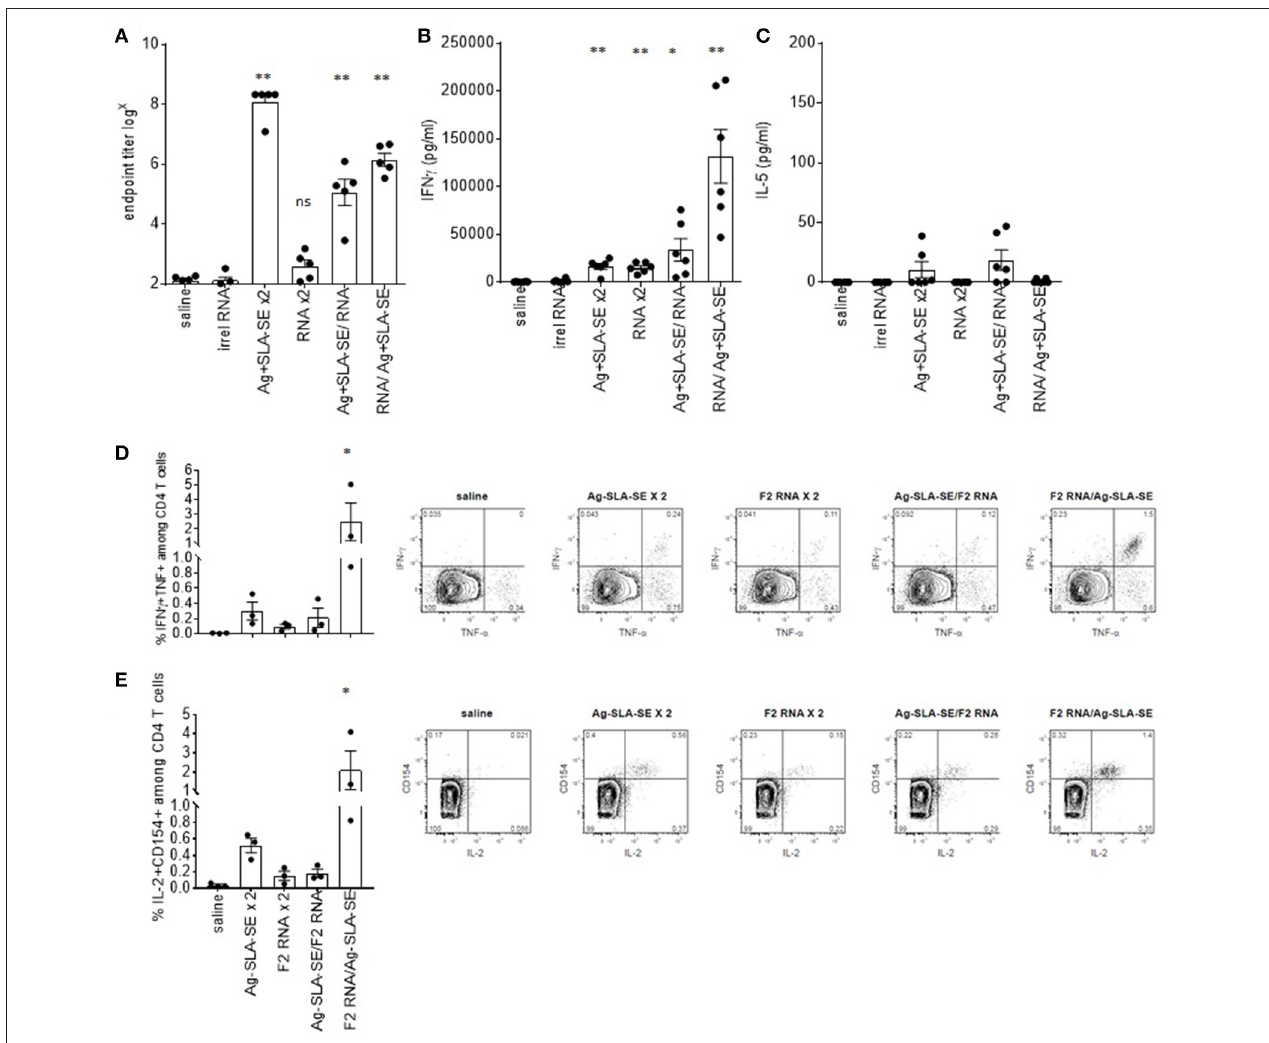
FIGURE 4 | Dichotomous generation of humoral and cellular immunity by subunit and RNA vaccines. C57BL/6 mice were immunized with the indicated homologous or heterologous regimen of vaccines. Four weeks after the boost, blood was collected and serum prepared, and spleens were removed and single cell suspensions prepared. In (A), the magnitude of the antigen-specific F2 IgG response was determined by dilution of each serum sample in ELISA until negative results were observed. Each point depicts the data from a single sample ( n = 5 per group), while the horizontal and vertical bars show the mean and SEM, respectively. Data are representative of results obtained in 3 independent experiments. Spleen cells were incubated with the F2 protein, then (B) IFN γ or (C) IL-5 concentrations in the culture supernatants was determined by ELISA. Cells were also subjected to flow cytometry to determine the relative proportion of CD4T cells simultaneously producing (D) IFN γ and TNF or (E) IL-2 an CD154. Data are shown as mean and SEM, n = 3–5 per group, and are representative of results obtained in 3 independent experiments. ns = not significant, and * and ** = p -value < 0.05 and < 0.01, respectively, when comparing the indicated group against the saline injected control